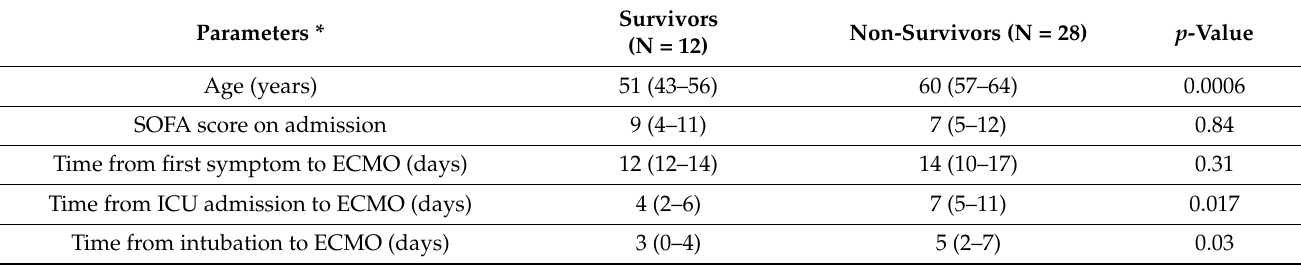
Table 4. Comparison of main characteristics between survivors and